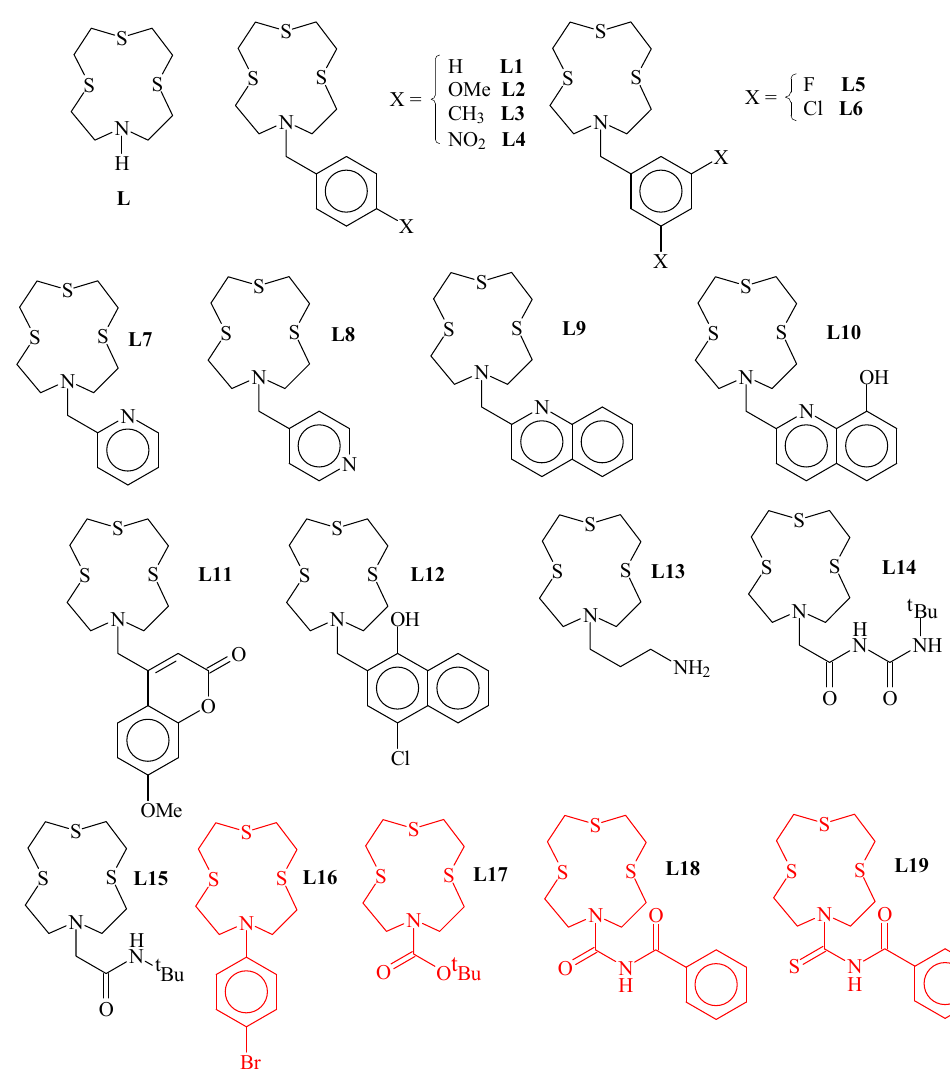
Figure 1. Summary of the crystallographically characterized [12]aneNS 3 ( L ) derivatives reported in the Cambridge Structural Database (CSD accessed on 13 January 2023) either as metal-coordinated ligands (drawn in black) or as free ligands (drawn in red). [ L H]Br·2H 2 O [1]; [Cd( L )(NO 3 ) 2 ] [2];